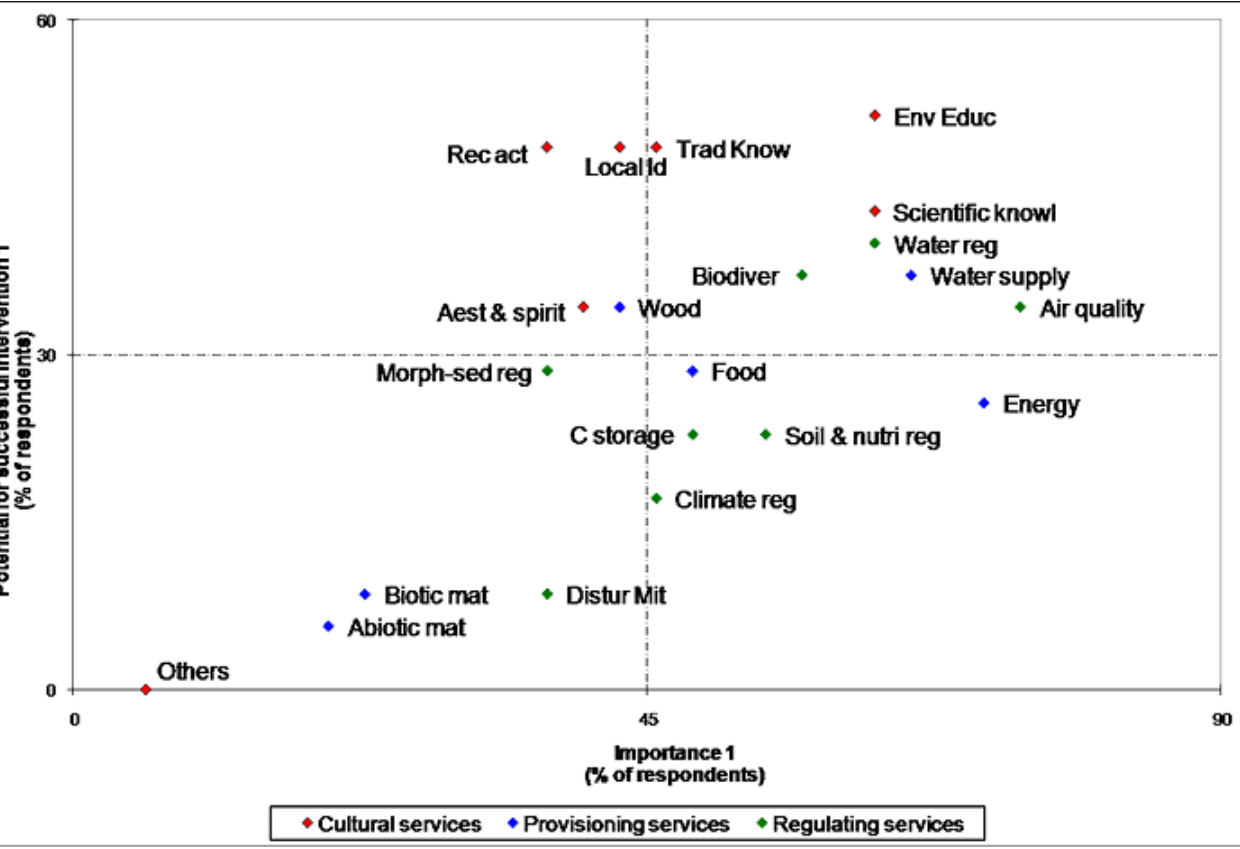
Fig. 2 . Scatter plot of the importance of ecosystem services of Biscay social ecological system and potential for successful intervention, according to the respondents. The X axes represent the percentages of respondents that consider each ecosystem service of the highest importance of the ranking (1 out of 4); whereas the Y axes represent the percentages of respondents that consider each ecosystem service with the highest potential for successful intervention (1 out of 4). Name codes: Env Educ = Environmental education, Trad Know = Traditional knowledge, Local Id = Local identity, Rec Act = Recreational activities, Aest & Spirit = Aesthetic and spiritual values, Scientific Knowl = Increases in scientific knowledge, Water reg = Water regulation, Biodiver = Biodiversity, Morph-sed reg = Morpho-sedimentary regulation, C storage = Carbon storage, Soil & nutri reg = Soil and nutrient regulation, Climate reg = climate regulation, Distur mit = disturbance mitigation, Biotic mat = biotic matirials, Abiotic mat = Abiotic